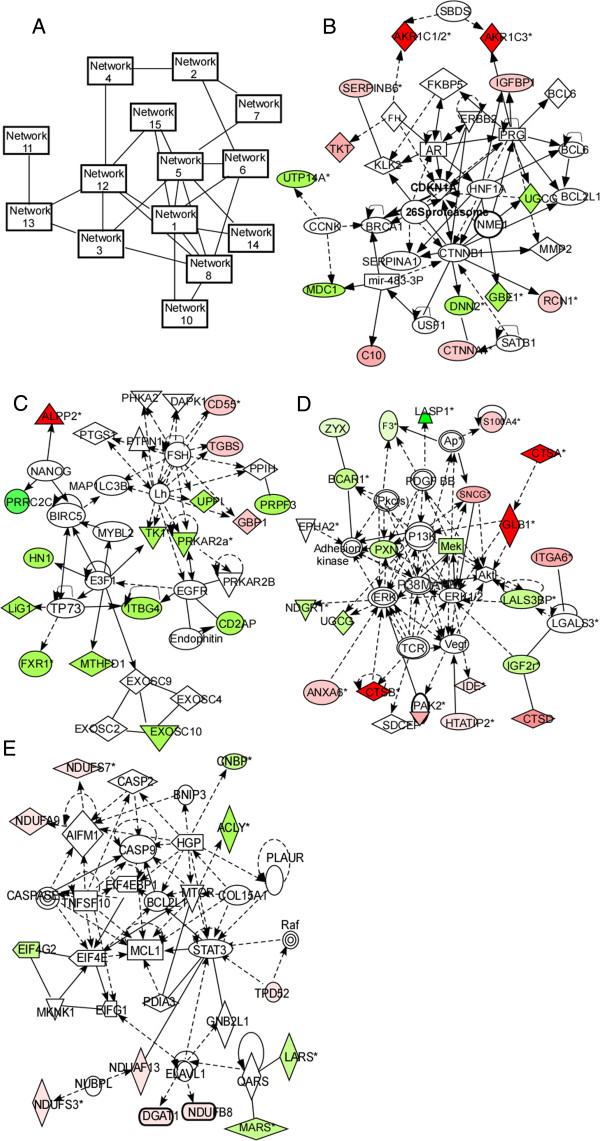
Ingenuity Pathway Analysis of proteins induced by DNP.A, overview of 15 specific functional networks, each of which contains 11 or more “focus” proteins (proteins that were significantly up- or down-regulated). Each box contains an arbitrary network number. B, cancer, renal and urological disease, and cell death. C, cancer, reproductive system disease, and cell death. D, cellular movement, lipid metabolism, and molecular transport. E, protein synthesis, cell death, and cellular growth and proliferation. Red, up-regulated proteins; Green, significantly down-regulated proteins; White, proteins known to be in the network but were not identified in our study. The color depth indicates the magnitude of the change in the protein expression level. Lines connecting the molecules indicate molecular relationships. Dashed lines indicate indirect interactions, and solid lines indicate direct interactions. The arrow styles indicate specific molecular relationships and directionality of the interaction. Abbreviations are shown in Additional file 2: Table S2.